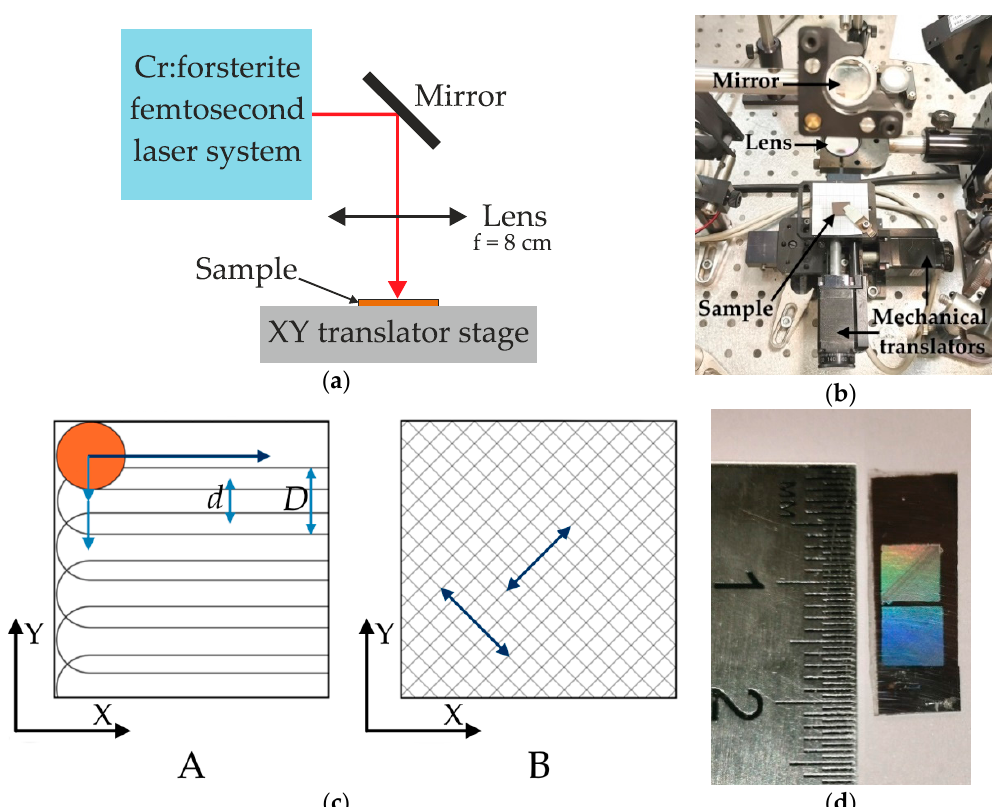
Figure 1. ( a ) Scheme of experimental setup used for processing the a-Si:H films by femtosecond laser pulses. ( b ) Photo of experimental setup. ( c ) Scanning mode templates used during a-Si:H femtosecond laser modification. ( d ) Photo of the areas at a-Si:H film surface, laser-modified in scanning mode